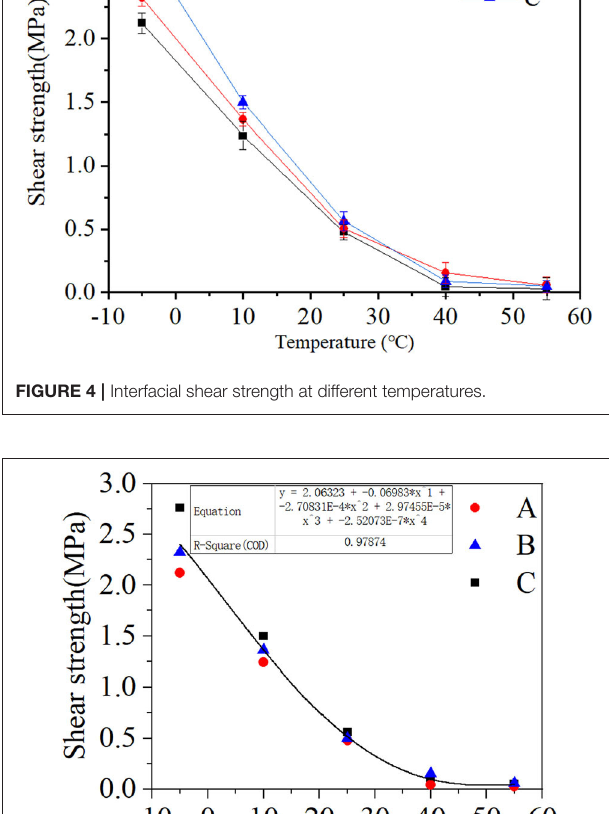
This equation can predict the interface bonding strength at different temperatures and guide the construction process of pothole repair.